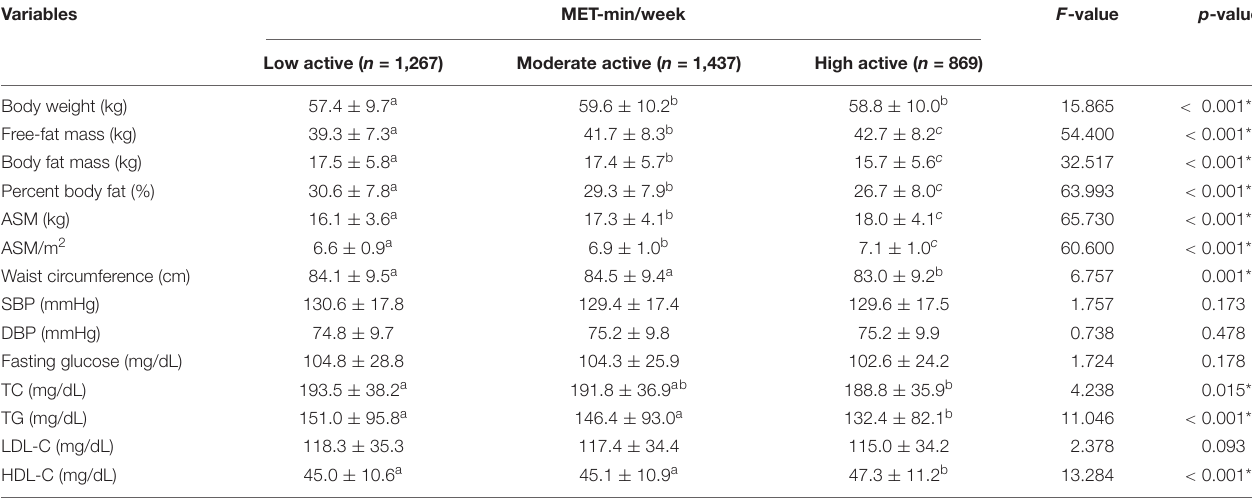
TABLE 3 | Cardiometabolic risk factors according to physical activity among Korean